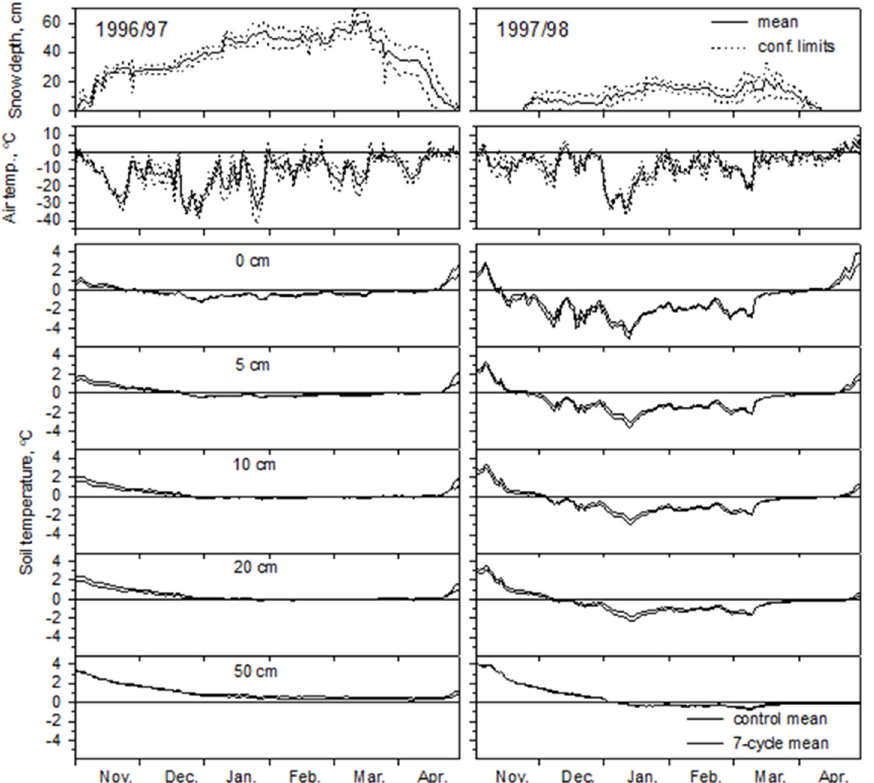
Figure 3. Snow depth and daily minimum air temperatures for a winter with normal snowfall (1996–1997) and below normal snowfall (1997–1998). Values are the mean (solid lines) and the confidence limits (dashed lines) for the 9 sites each winter.